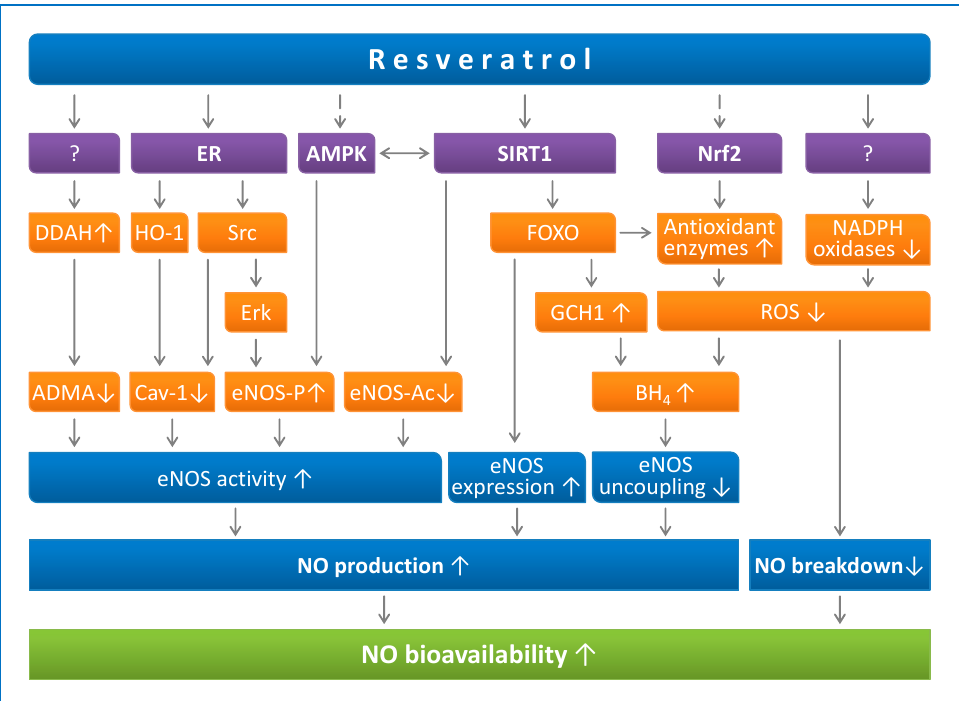
Figure 1. Resveratrol enhances NO production and prevents NO breakdown. Resveratrol can activate sirtuin 1 (SIRT1) directly (in a substrate-dependent manner) or indirectly (by either inhibiting phosphodiesterases or enhancing the e ff ect of lamin A). SIRT1 stimulates endothelial NO synthase (eNOS) activity through deacetylation, enhances eNOS expression by deacetylating Forkhead box O (FOXO) transcription factors, and prevents eNOS uncoupling by upregulating GTP cyclohydrolase 1 (GCH1), the rate-limiting enzyme in tetrahydrobiopterin (BH4) biosynthesis. AMP-activated protein kinase (AMPK) and nuclear factor-erythroid-derived 2-related factor-2 (Nrf2) are indirect targets of resveratrol. AMPK phosphorylates eNOS at serine 1177. eNOS can also be phosphorylated by Erk1 / 2, which is stimulated by a pathway involving estrogen receptors (ER) and the tyrosine kinase Src. Caveolin-1 (Cav-1) is an eNOS-interacting protein that negatively regulates eNOS activity. Asymmetric dimethylarginine (ADMA) is an endogenous eNOS inhibitor that is degraded by dimethylarginine dimethylaminohydrolase (DDAH). The resveratrol targets for DDAH upregulation or for NADPH oxidase downregulation have not been identified so far. Reproduced from Xia et al. Molecules . 2014 [46], under the terms of the Creative Commons Attribution-Noncommercial License